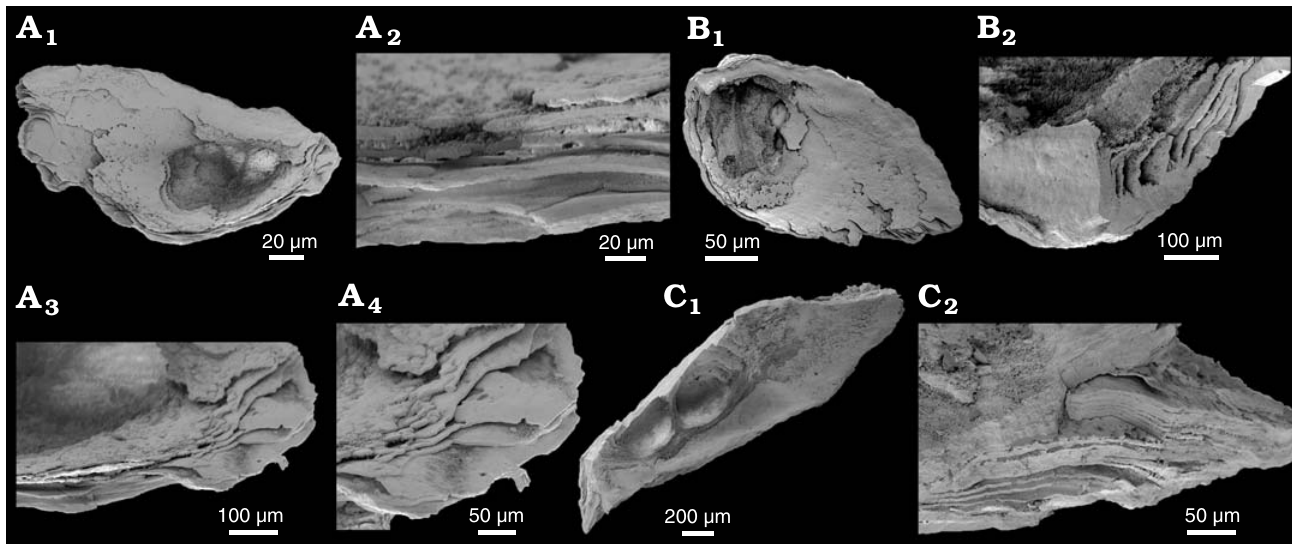
Fig. 12. Shell microstructures of Cordatia erinae Brock and Claybourn gen. et sp. nov. from the lower Cambrian White Point Conglomerate, Kangaroo Island, South Australia. A . SAM P57308, ventral valve in oblique internal view (A 1 ); A 2 –A 4 , details of laminar shell microstructure. B . SAM P57309, dor- sal valve in oblique internal view (B 1 ); B 2 , detail of laminar shell microstructure. C . SAM P57310, shell fragment in oblique internal view (C 1 ); C 2 , detail of laminar shell